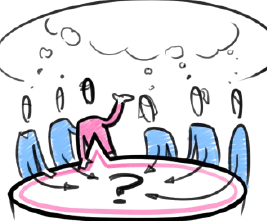
Source of scheme: the authors of this